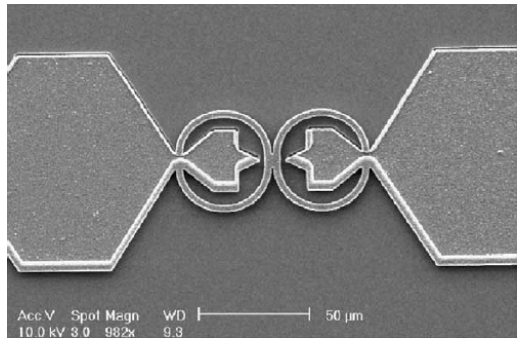
Figure 8. Top view of the double ring sample [32]. Reproduced with permission from